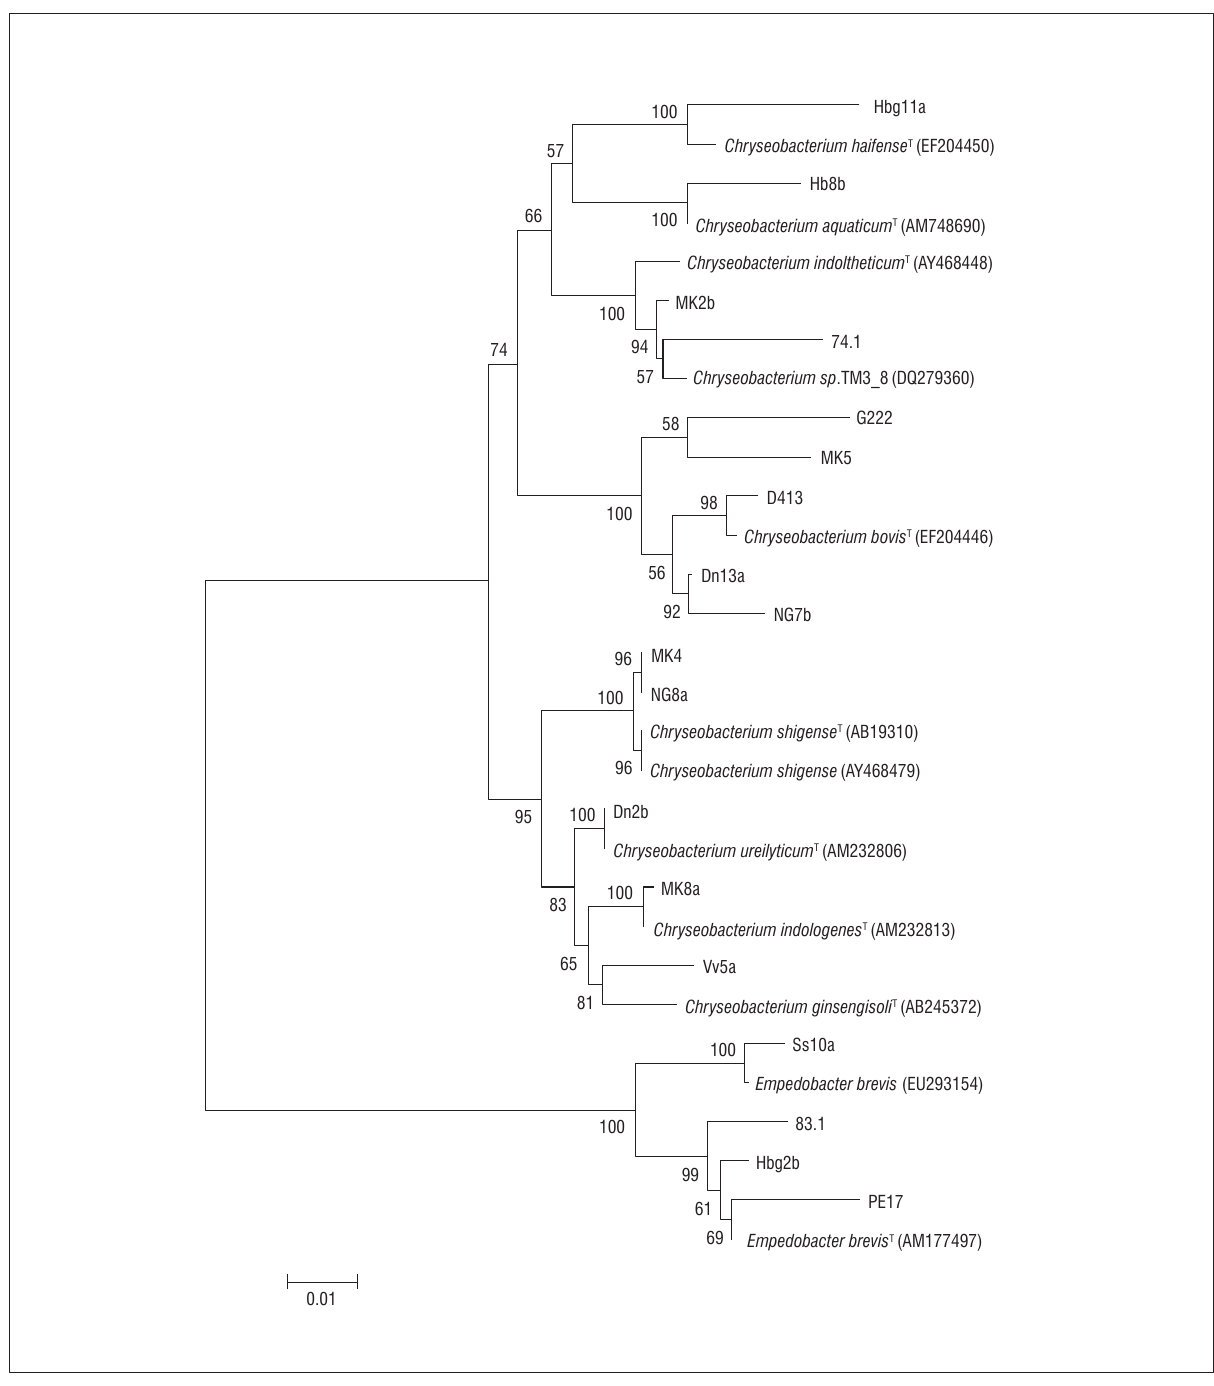
Figure 1: Neighbour joining phylogenetic tree showing relationships of the 18 dairy isolates from this study and closely related species from the GenBank database (accession numbers are given in parentheses). Bootstrap values are indicated at the nodes for 1000 replicates. The bar represents 10 substitutions per 100